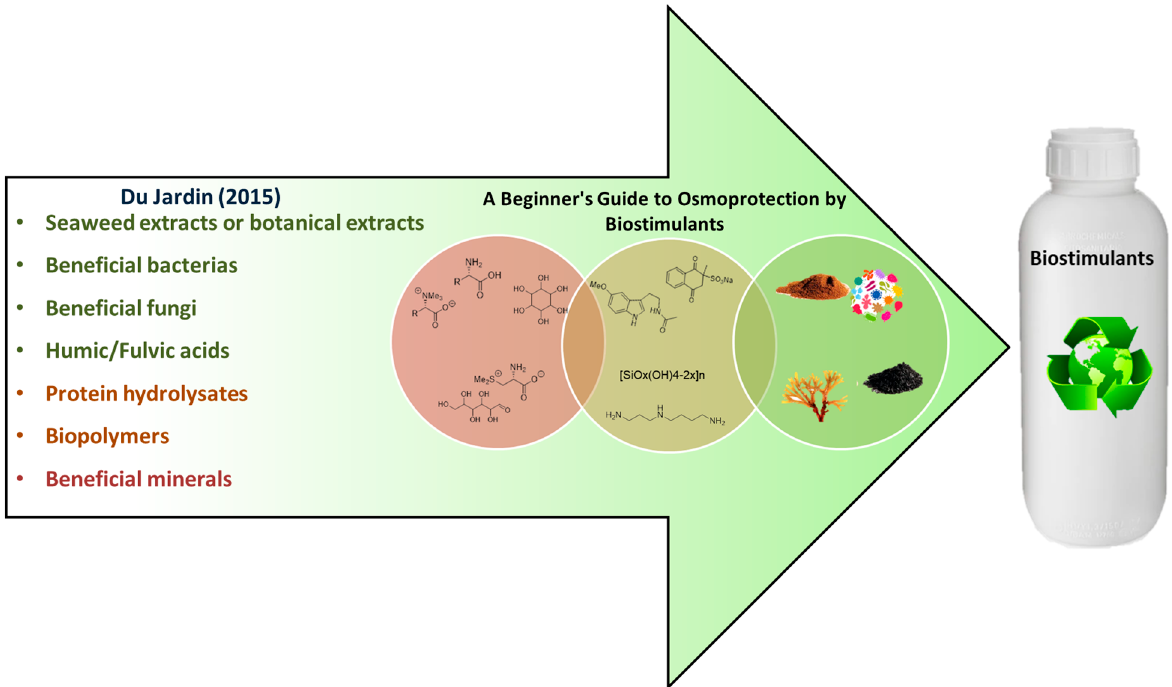
Figure 2. Graphical summary of the components listed in the review: in red, naturally accumulated plant osmoprotectants; in brown, natural and non-natural plant protectant compounds; and in green, hydrolysed biological extracts and microorganisms.